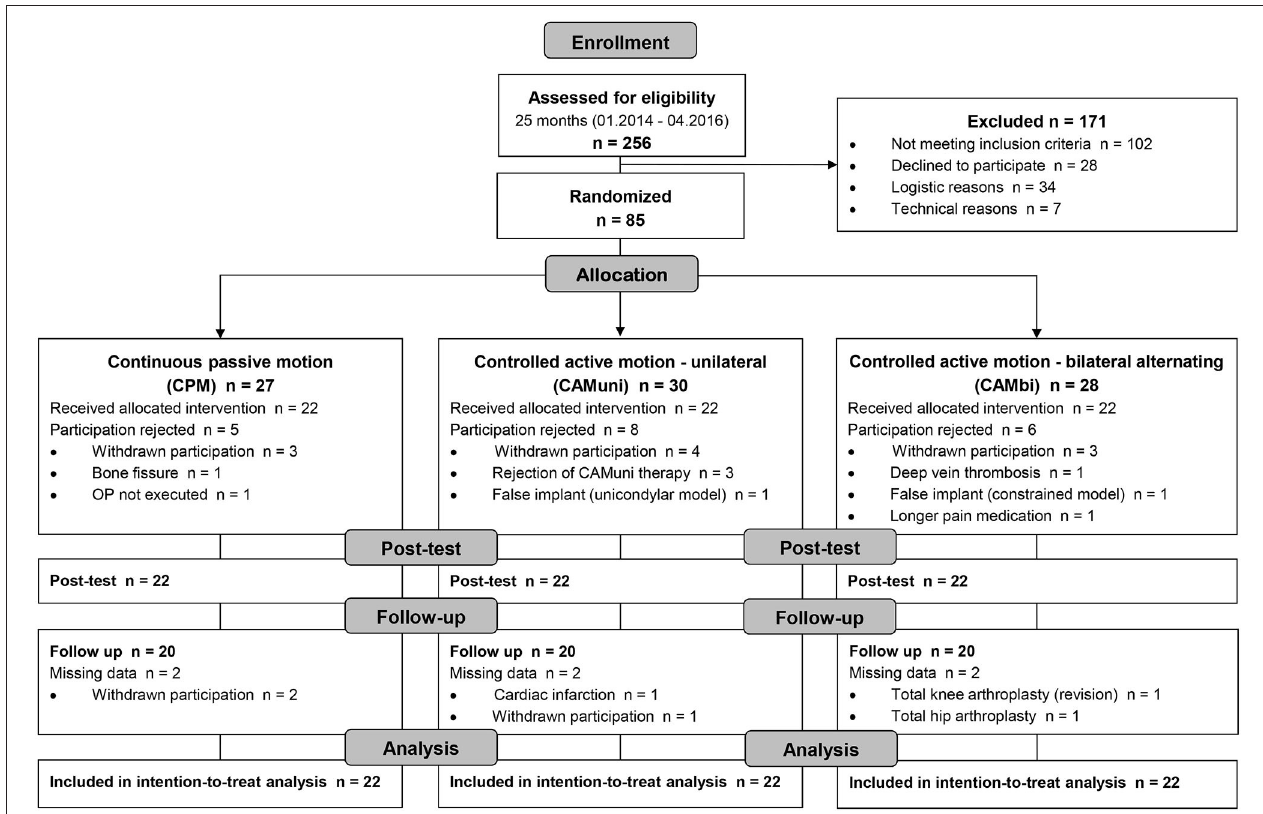
FIGURE 2 | Consort participant flow diagram showing enrollment, intervention allocation, number of participants at different time points, and number of patients included in modified intention-to-treat analysis.